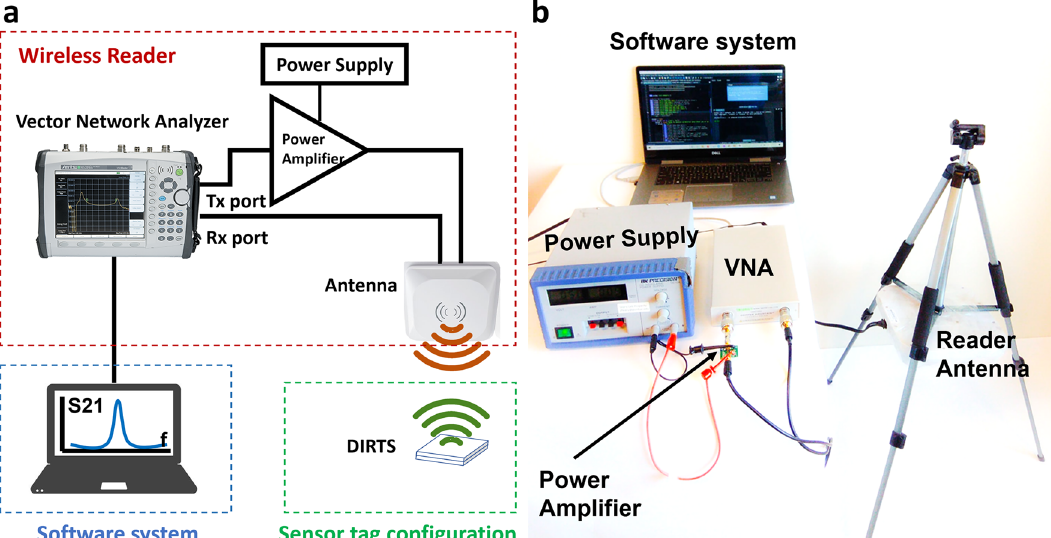
Figure 4. Wireless reader development ( a ) Schematic illustration of the various building blocks of the custom- designed portable readout unit. ( b ) Picture of the implemented portable system consisting of the antenna, VNA and its accessories, and the software